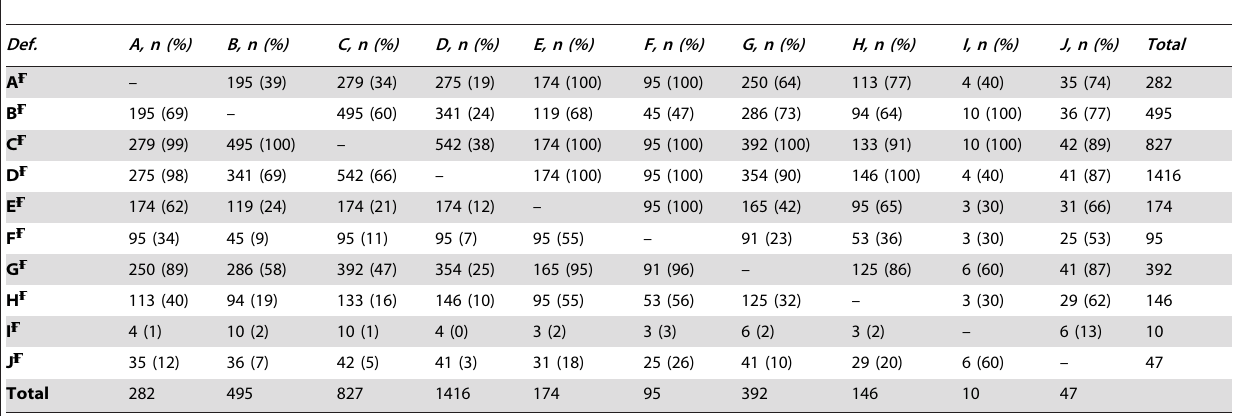
Example: 95 seroconverters were classified as EC by definition F of whom 25 (26%) were classified as EC by definition J. Conversely, of 47 seroconverters classified as EC by definition J, 25 (53%) were classified as EC by definition F.